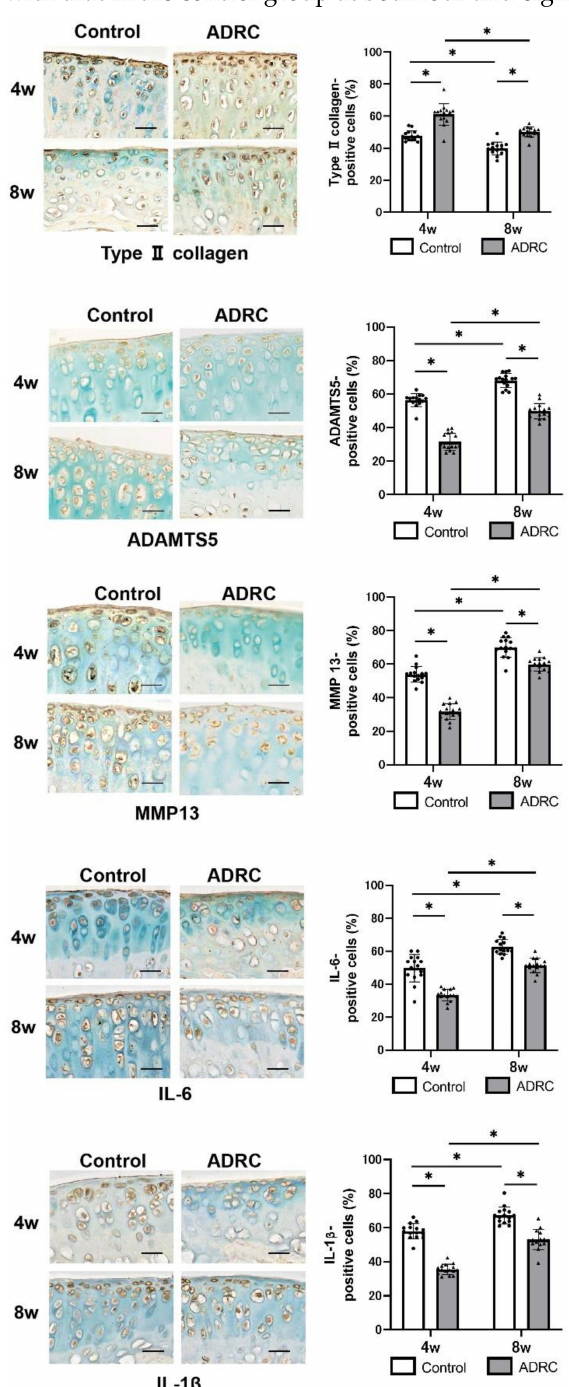
Figure 3. Immunohistochemical analyses of type II collagen, cartilage degrading enzymes, and inflammatory cytokines. Representative images at four and eight weeks after transplantation. Graphs show the ratio of the number of positive cells to the number of total cells for each protein at four and eight weeks after transplantation. Asterisk indicates a statistically significant difference. Scale bars = 50 µ